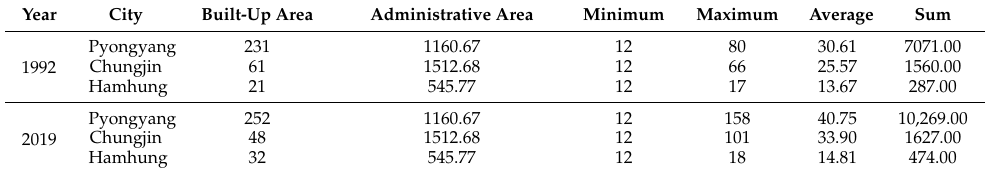
Table 3. Statistical results for relevant indicators of light intensity in typical cities in DPRK [km 2 ].